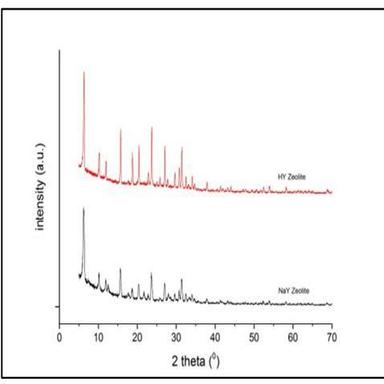
XRD Comparison BetweenNaY and HY Zeolite